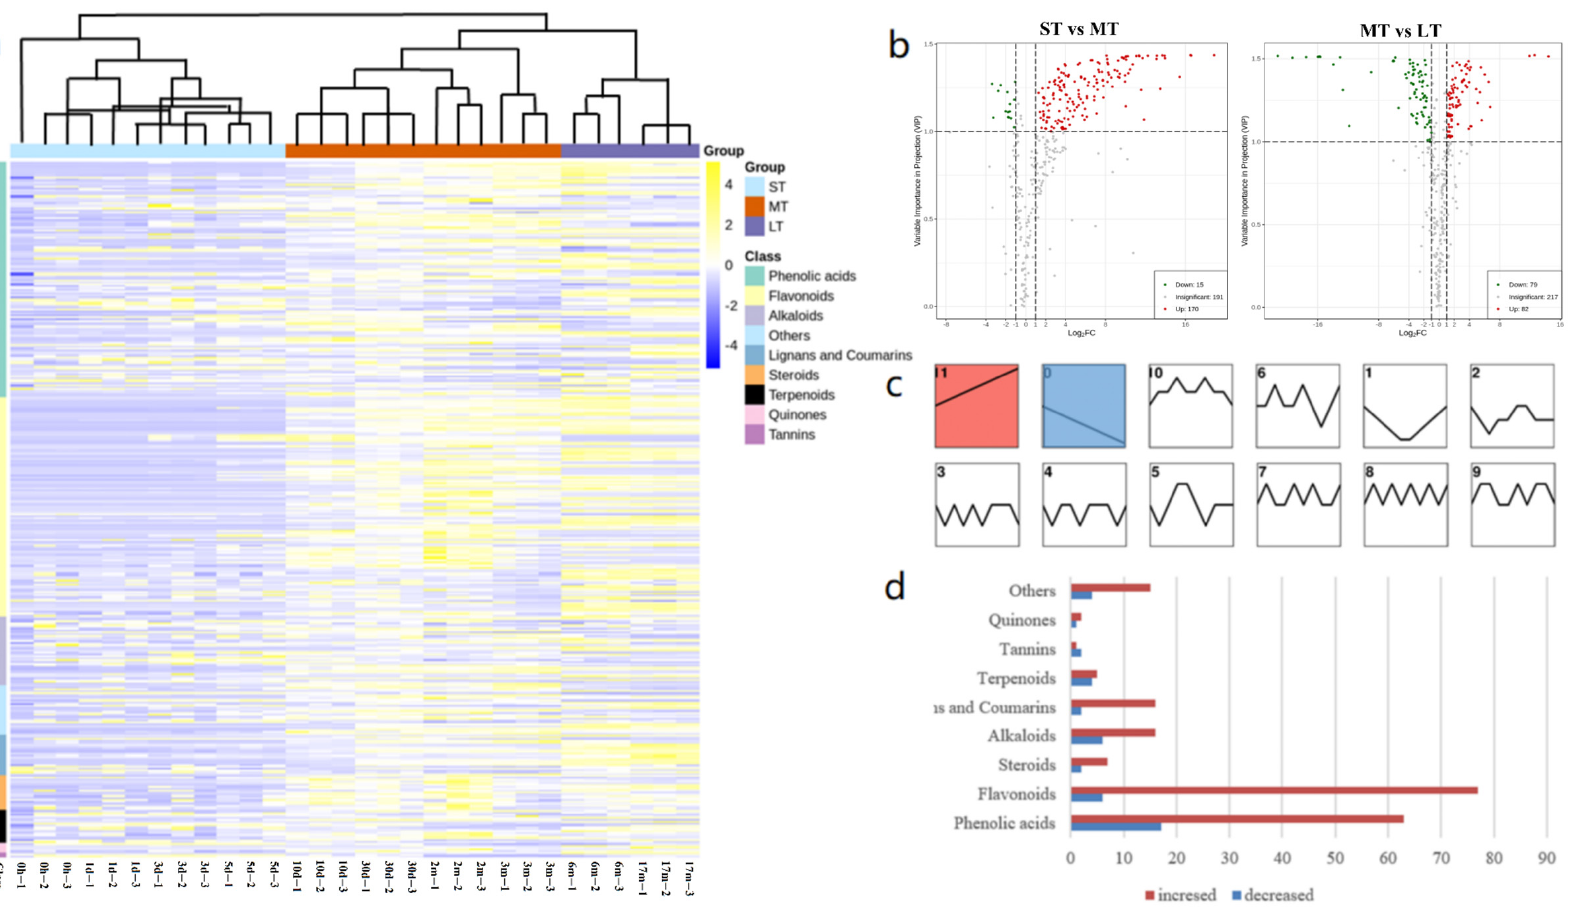
Figure 1. Secondary metabolites of D. cochinchinensis stems at different times after wounding: ( a ) heatmap and clustering of metabolic profile of samples at different times after wounding; ( b ) volcano plot of samples in different stages after wounding; ( c ) trend analysis result of samples over time after wounding; ( d ) types of compounds in trend 11 and 0.